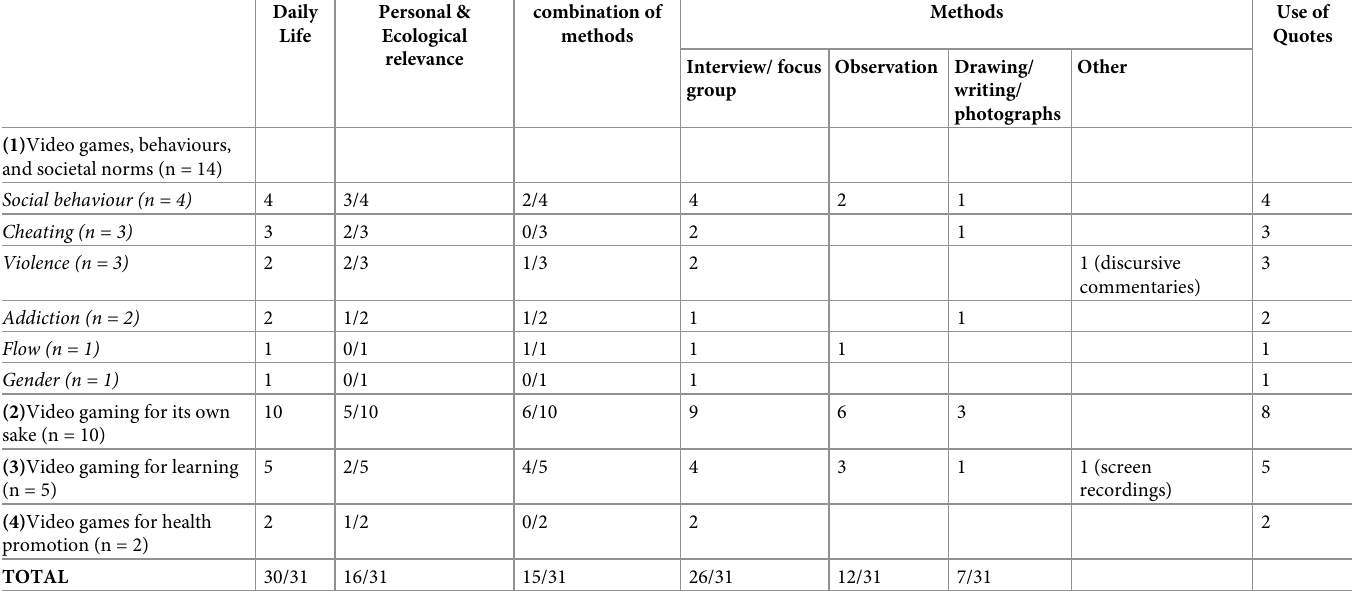
Table 3. Overview of data